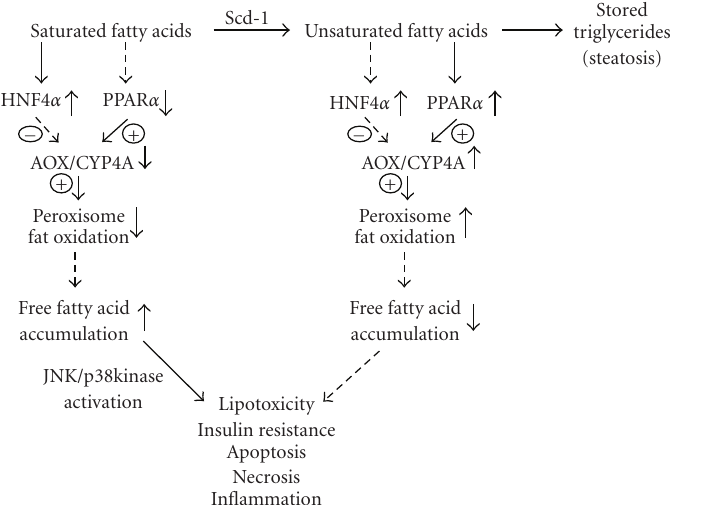
Figure 1: Schematic diagram of the role of saturated fatty acids in causing nonalcoholic fatty liver diseases and lipotoxicity. The positive signs with solid lines represent activation and/or upregulation of the downstream targets while the negative signs with broken lines indicate the opposite e ff ects. Abbreviations used are HNF4 α , hepatocyte nuclear factor 4; PPAR α , peroxisome proliferator activator receptor α ; AOX, acyl-CoA oxidase; CYP4A, cytochrome P450 4A; Scd-1, stearoyl-CoA